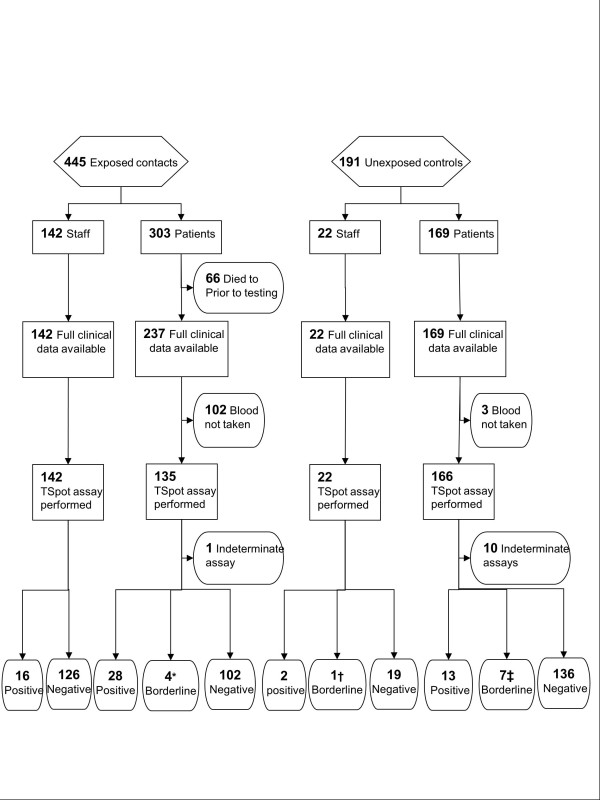
Study flow chart showing all participant cohorts. * comprises 3 borderline positive, 1 borderline negative; † comprises 1 borderline negative; ‡ comprises 5 borderline positive, 2 borderline negative.